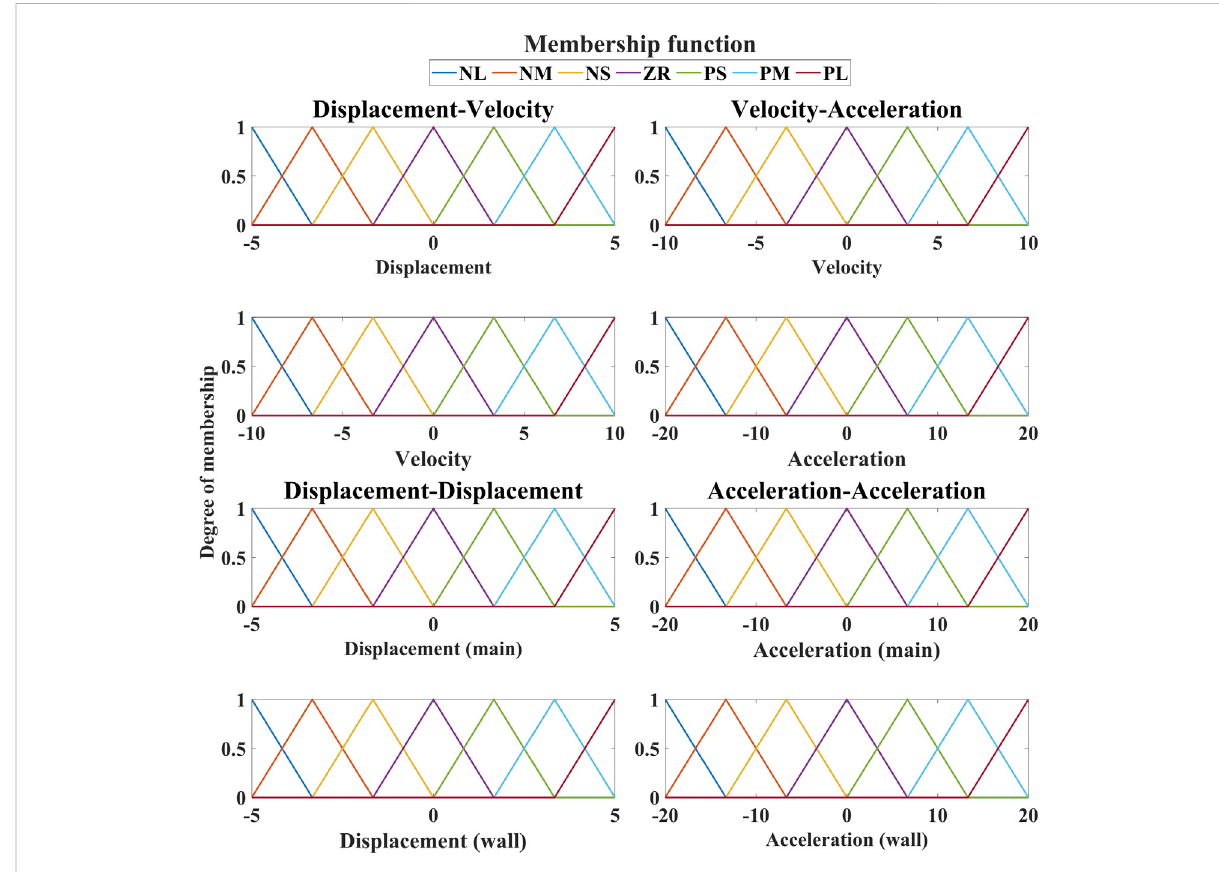
FIGURE 5 Member functions of the fuzzy logic controller in each case.